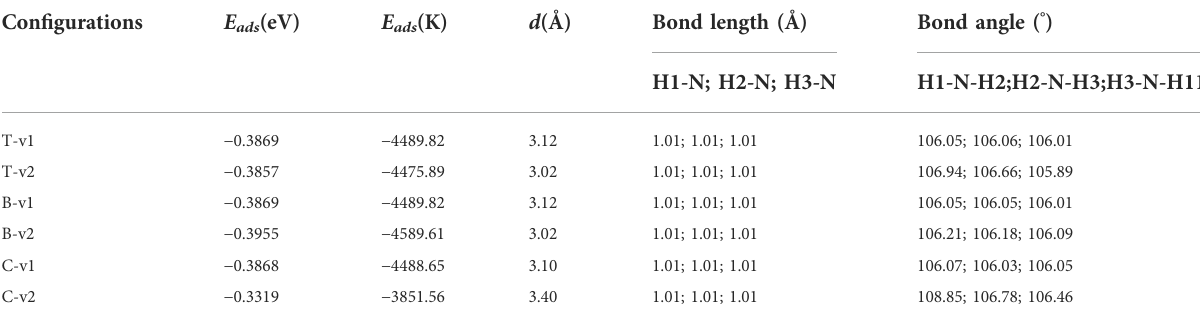
TABLE 2 NH 3 on the graphene-like surface: E ads , d and the bond length and bond angle of NH 3